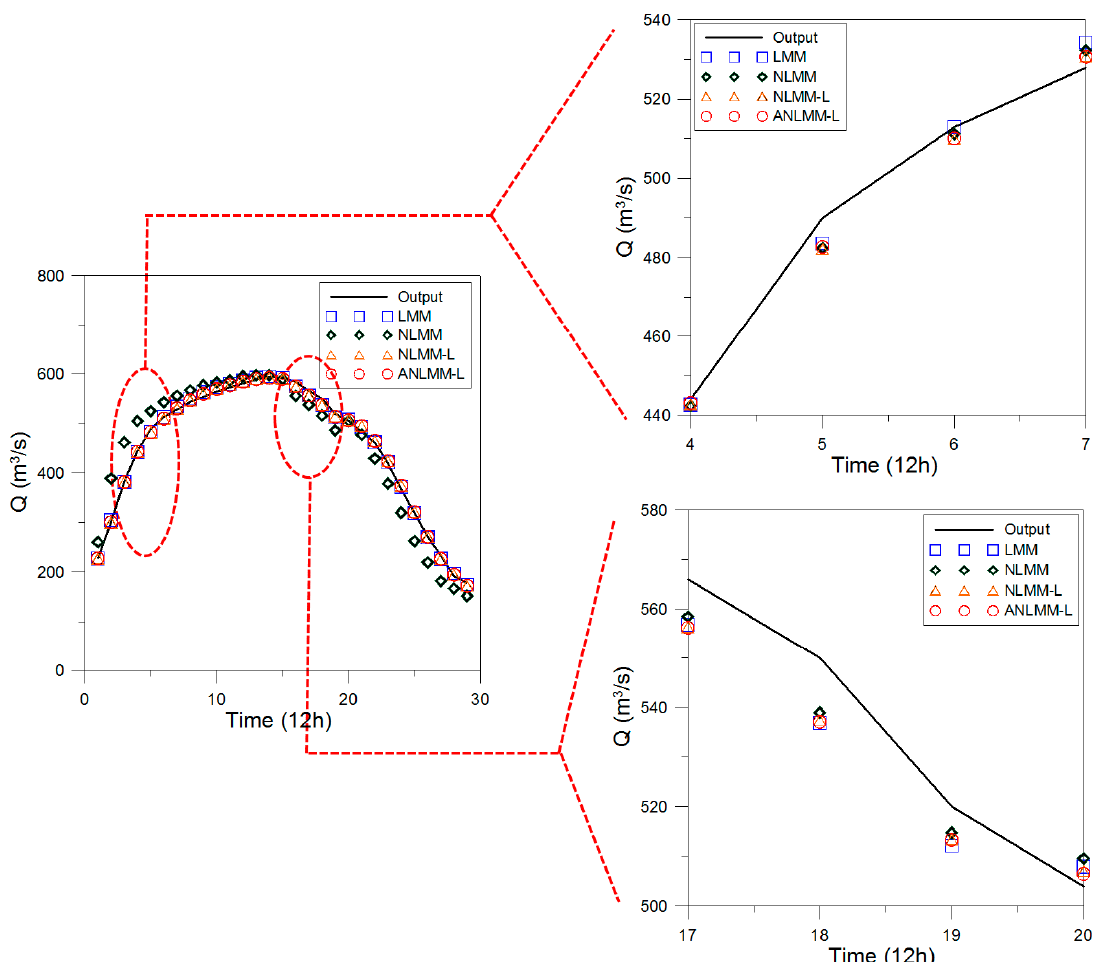
Figure 3. Comparison of results for Wang et al.’s flood data [10].